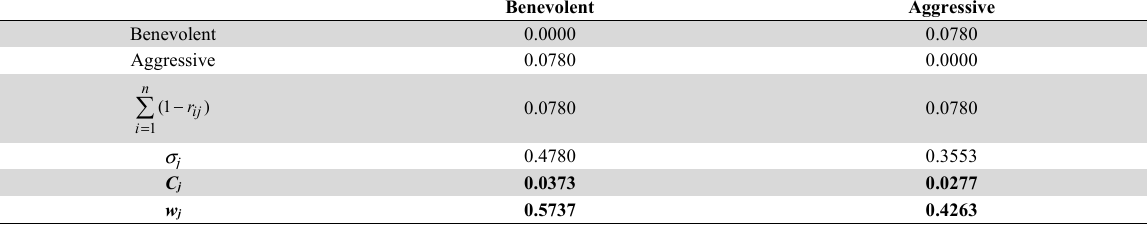
Criteria weights for six nursing homes using the CRITIC method